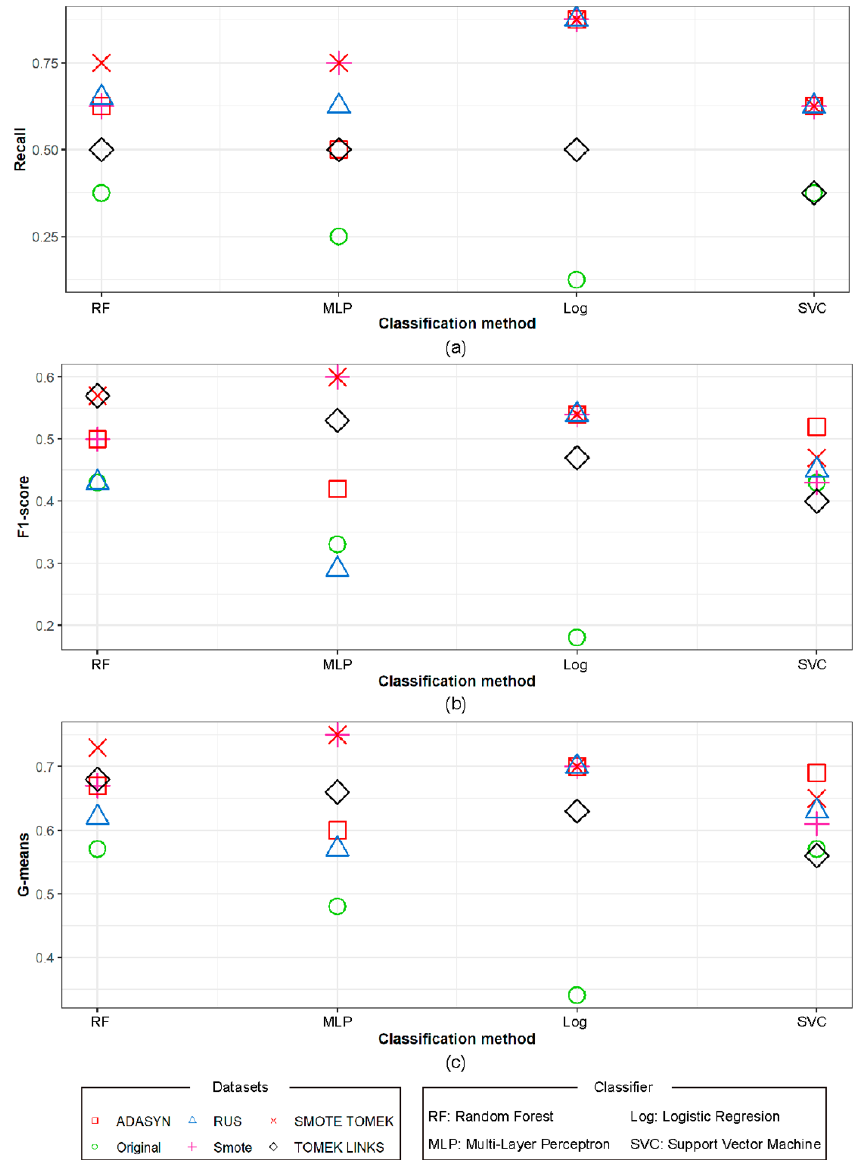
Figure 7. Accuracy of wildfire size prediction based on ( a ) Recall, ( b ) F1-score, and ( c ) G-means.